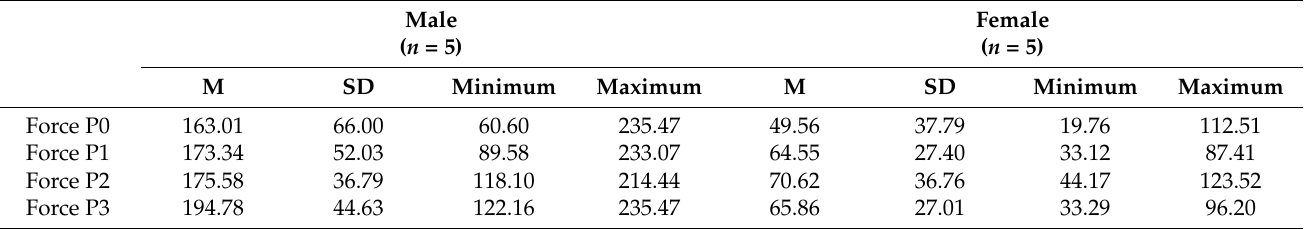
Table 9. Means (M), standard deviations (SD), minimums, and maximums for the independent